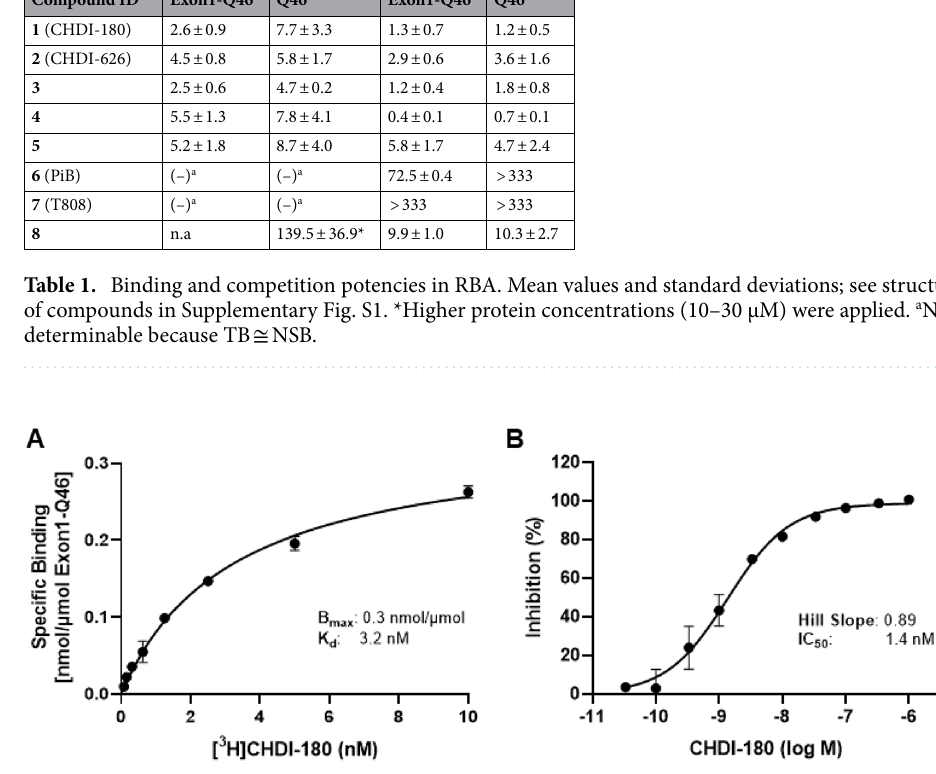
Figure 2. RBA applications. ( A ) Saturation binding to determine maximal binding (B max ) and binding affinity (K d ) values of radioligand CHDI-180 for binding to recombinant Exon1-Q46 aggregates. ( B ) Competition binding of CHDI-180 against tritiated 3 to determine IC 50 value of compound. Note: Representative graphs of single experiments with triplicate data points are shown. Mean K d and IC 50 values (n = 5) for CHDI-180 are shown in Table